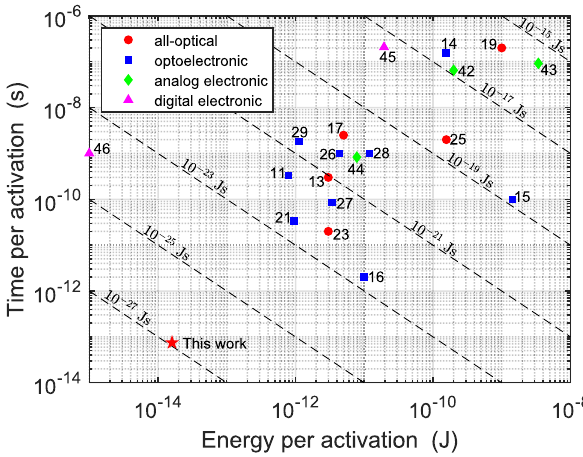
Figure 7: Comparison of energy and time per activation of this work (red star) to previous all-optical (red circle), optoelectronic (blue square), analog electronic (green diamond), and digital electronic (magenta triangle) nonlinear activation functions. The numeric labels show reference numbers and dashed black lines show the energy-time product